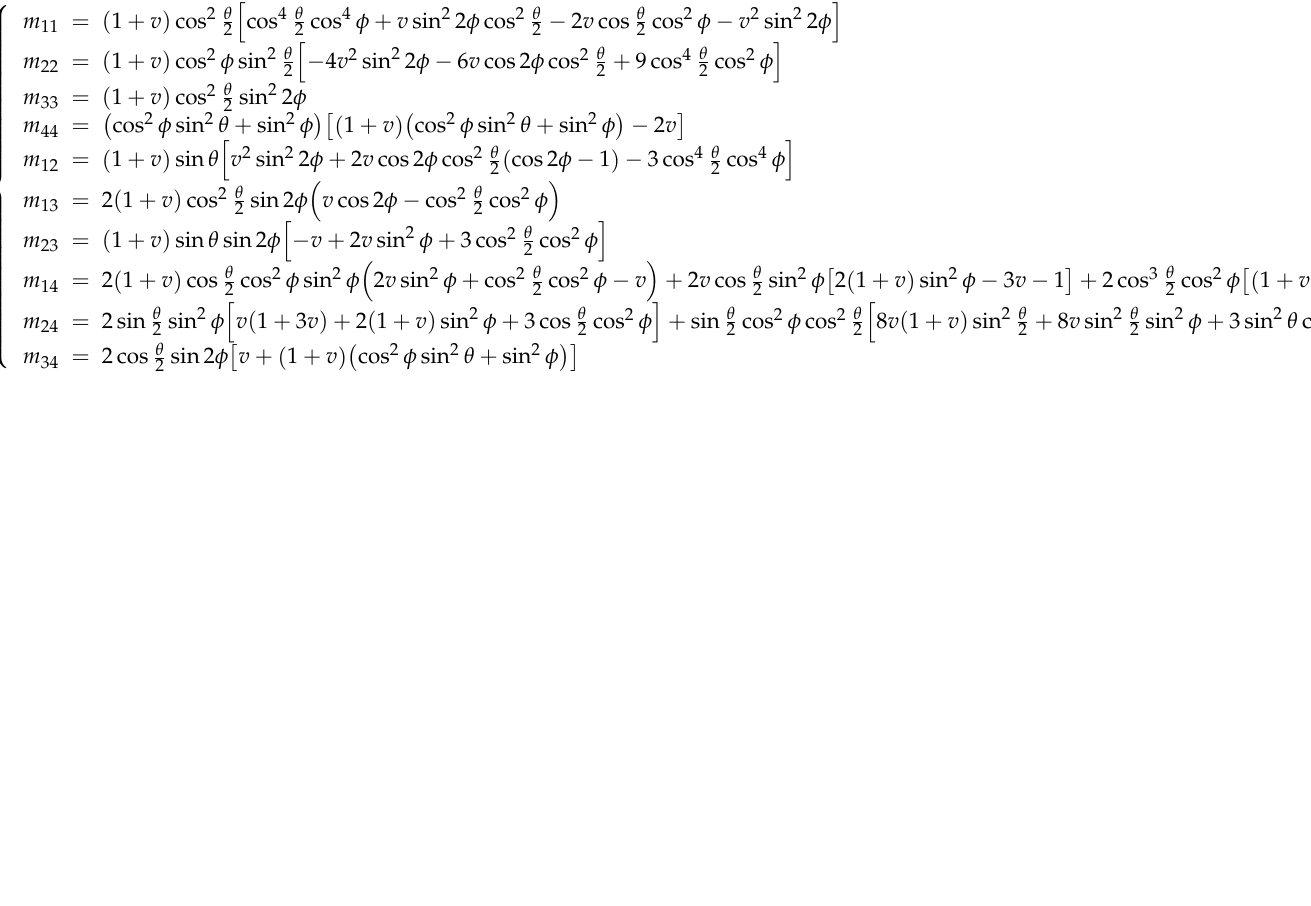
Table A4. The coefficients of Equation (12) under the plane strain